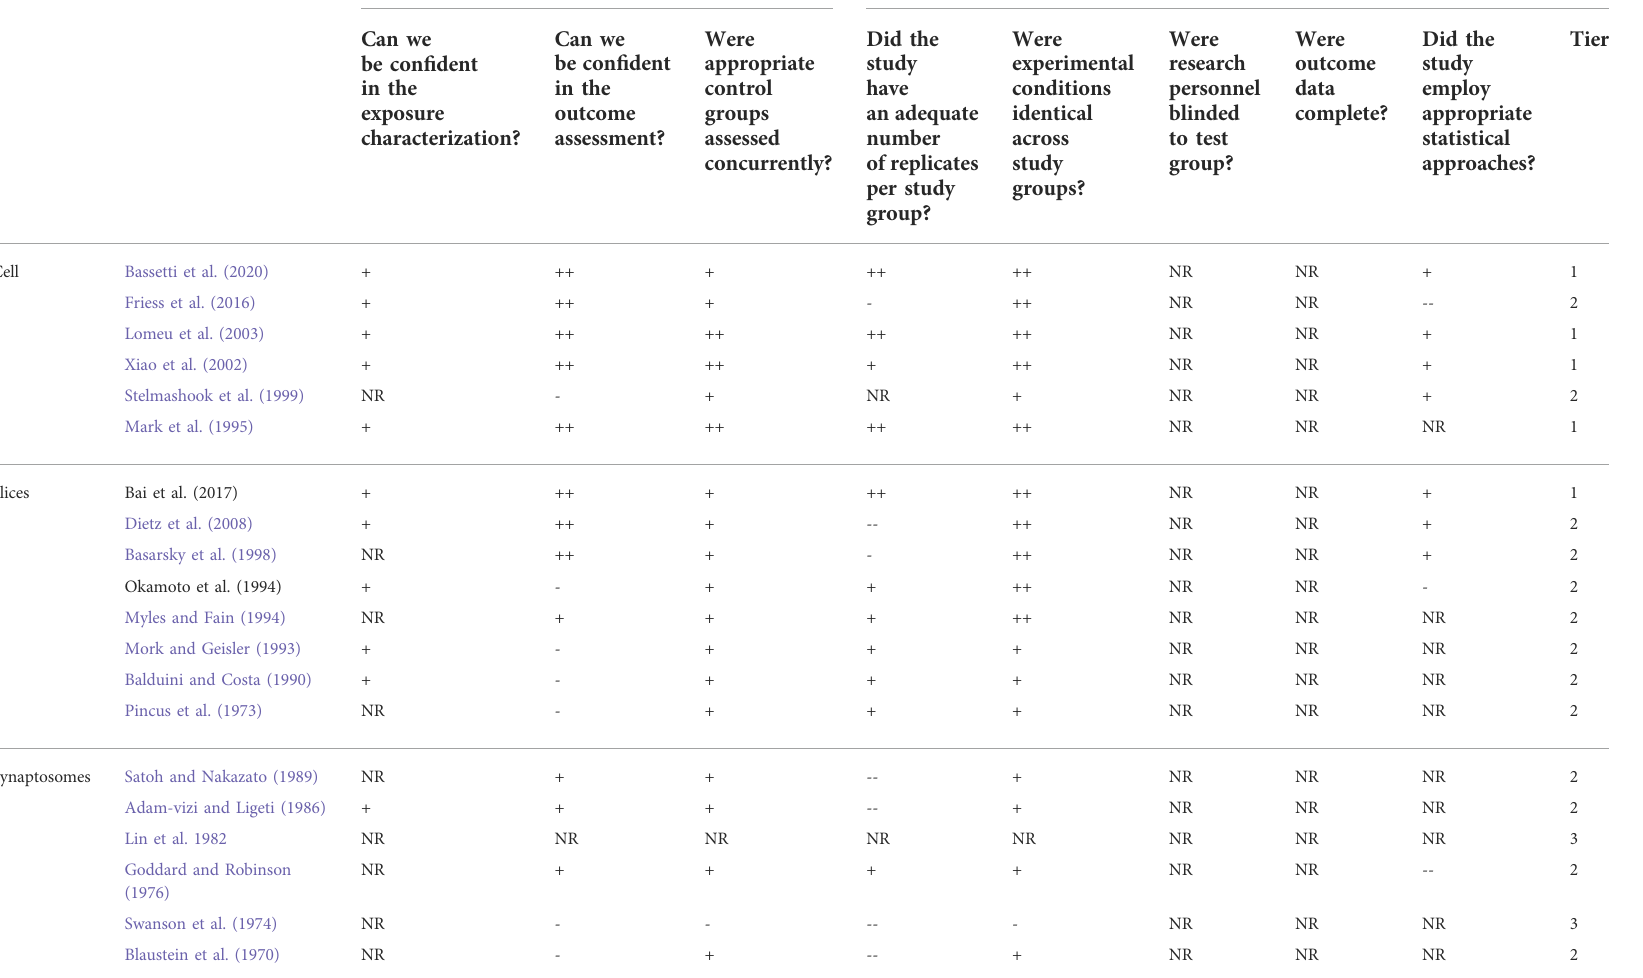
TABLE 1 Study quality/risk of bias